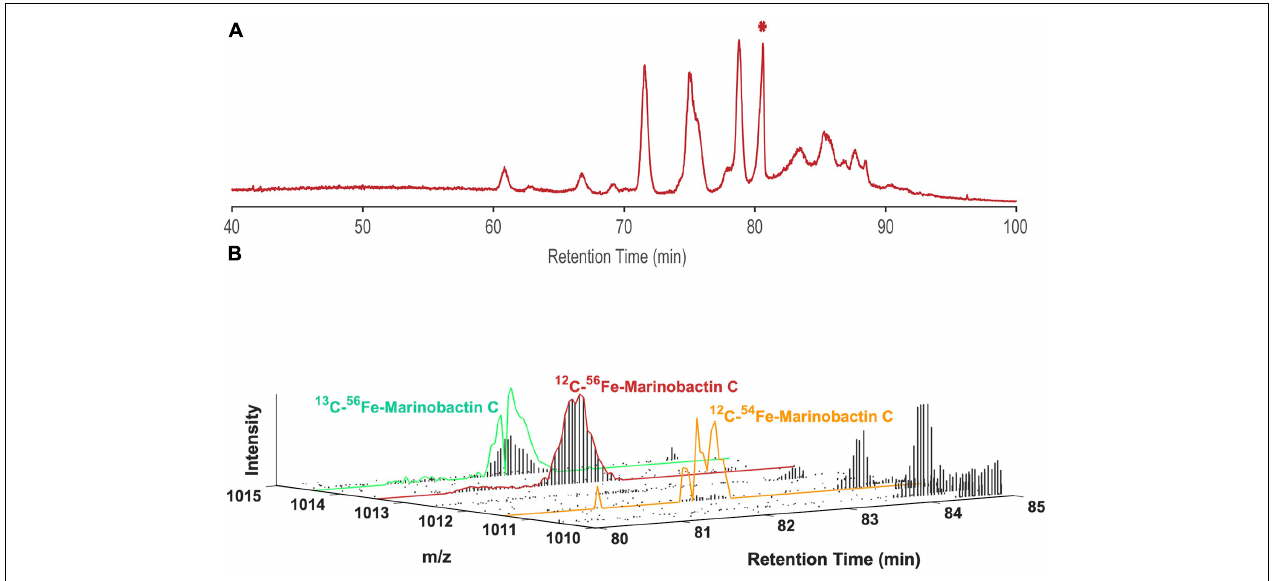
FIGURE 1 | (A) LC-ICPMS 56 Fe-chromatogram of dissolved organic matter collected by SPE from the North Pacific Ocean. Each discrete peak represents one (or a combination of multiple) Fe-containing organic compounds. The starred peak (*) at 80.6 min was selected as our target for characterization, and (B) LC-ESIMS data between 80–85 min and 1010.00 D-1015.00 D for the same sample. Using the isotope ratio search algorithm with (cid:49) m = 1.995 D and R = 15.7 for 54 Fe and 56 Fe the peak at 80.6 min was assigned the m/z of 1013.44 D. It is then identified as marinobactin C (EIC outlined in red), by comparison of its exact m/z with a catalog of know siderophores. The scaled plots for 54 Fe-1011.45 D, and 13 C- 56 Fe-1014.44 D of marinobactin C are outlined in orange and green respectively. Each vertical black bar represents the ion intensity at each mass in a scan at a given retention